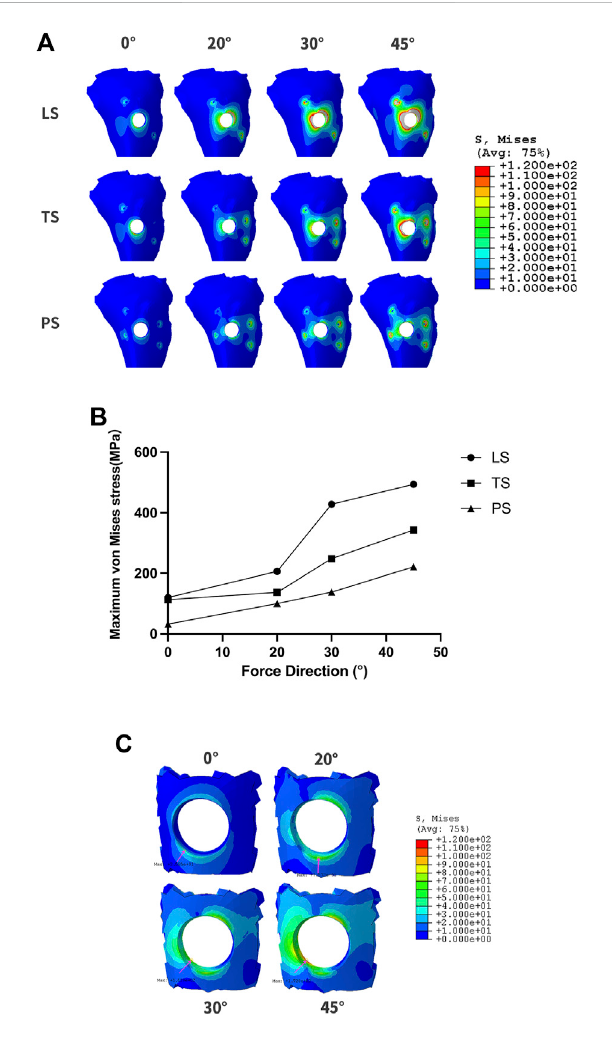
The changes of maximum von Mises stress according to different force directions and wing designs at RBH 1 mm. (A) . The diagram of maximum von Mises stress distribution; (B) . Value changes of maximum von Mises stress; (C) . The stress distribution at the hole-edge of the PS